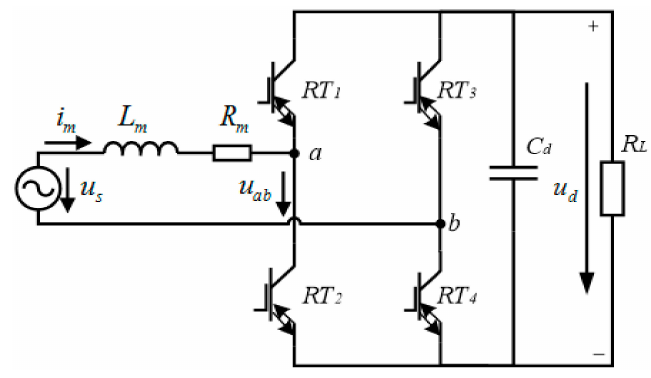
Figure 13. Diagram of the RC-IGBT single phase Voltage-source. Table 1. Work conditions of the PWM Rectifier in